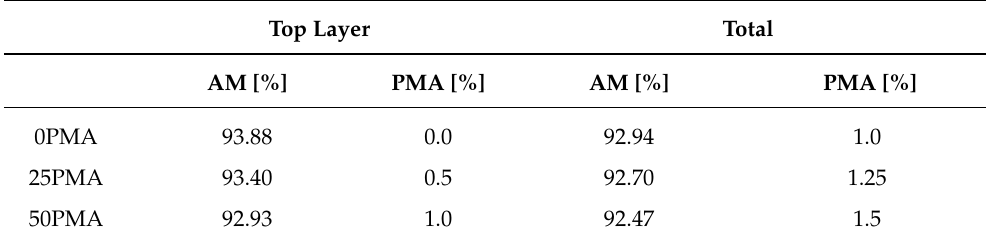
Table 1. Amount of active material and PMA in the slurry formulations of all samples.